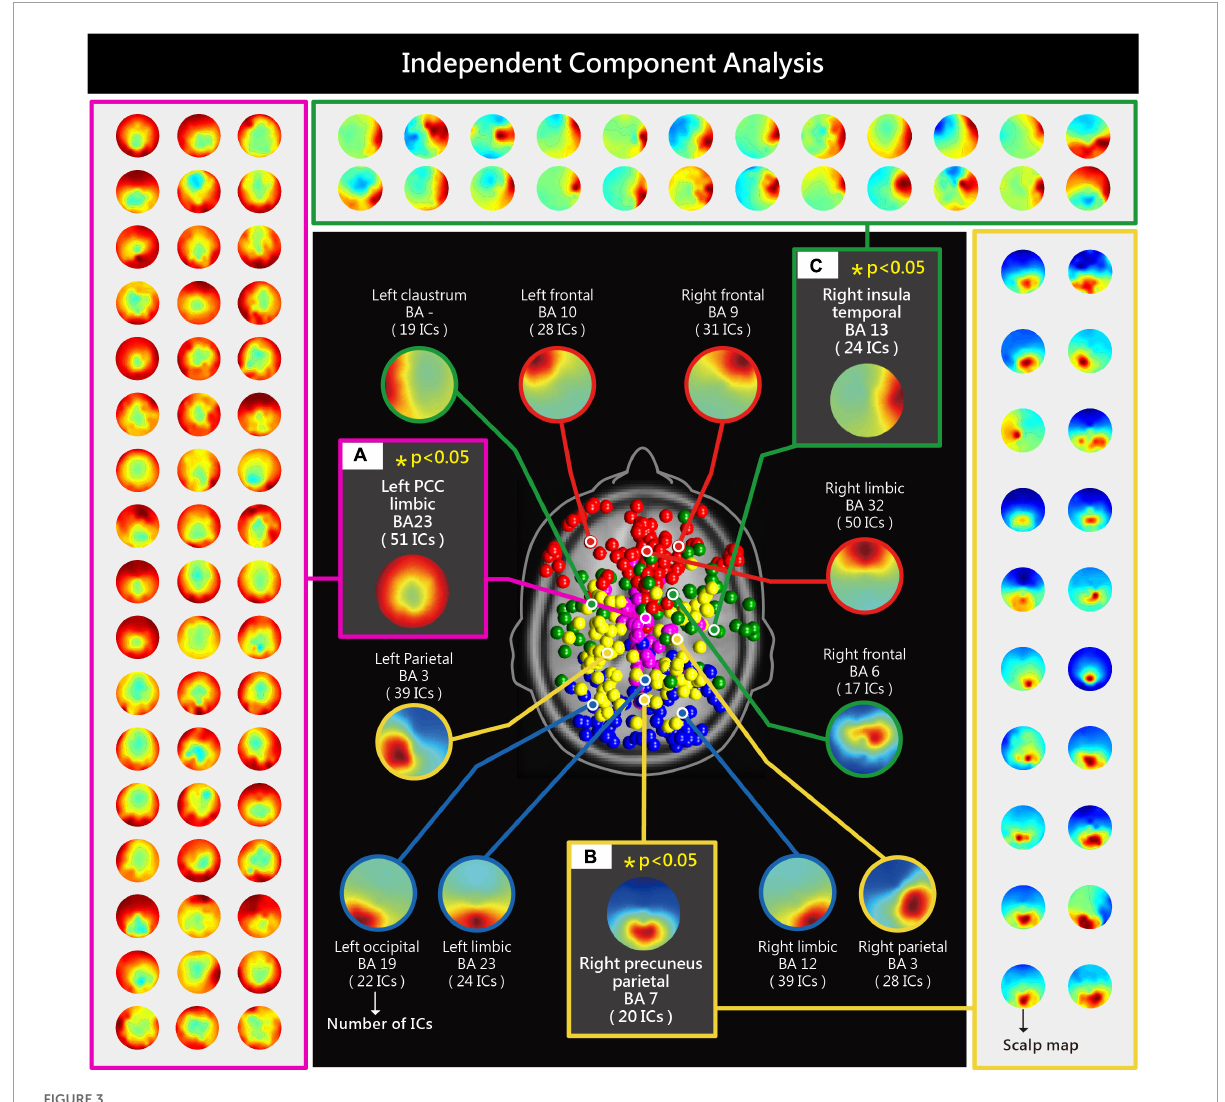
FIGURE3 Analysis of the spectral power of high/low levels of internal consumer responses (product comprehension, curiosity, preference, purchase intention) and surreal marketing images with different numbers of metaphorical sources revealed significant differences ( p < 0.05) in the following brain areas: left PCC (A) , right precuneus (B) and right insula (C)